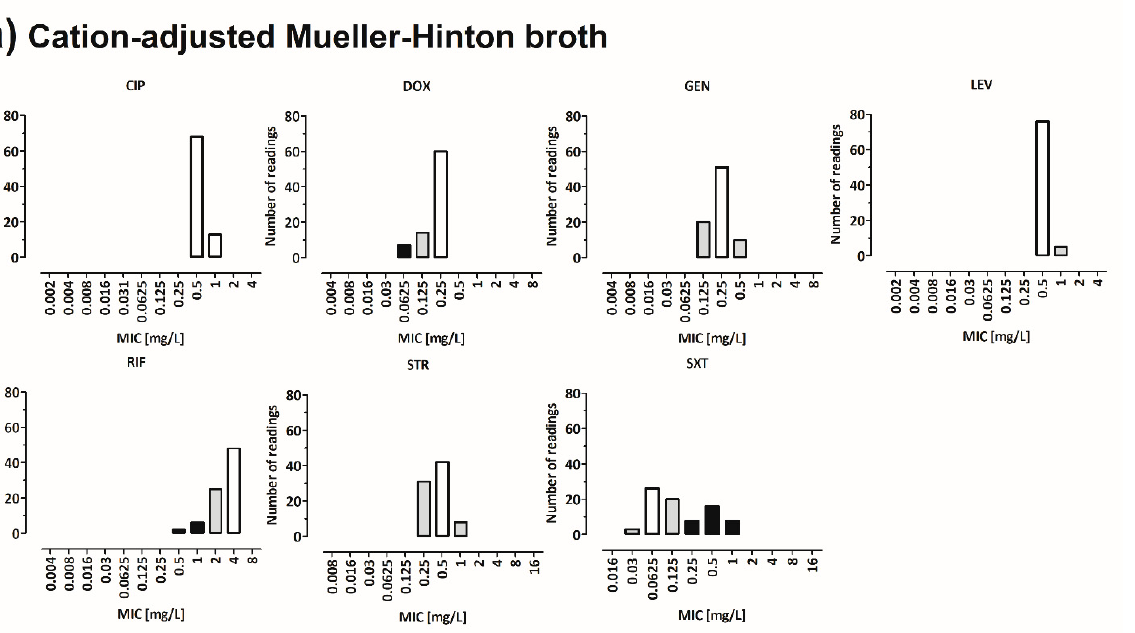
Figure 6. MIC values resulting from the interlaboratory validation (ILV) experiments where eight partner laboratories performed BMD with the B. melitensis clinical isolate Bm150048 using CAMHB ( a ). Four out of seven antimicrobials fulfilled the prerequisite to set a reference range: ciprofloxacin